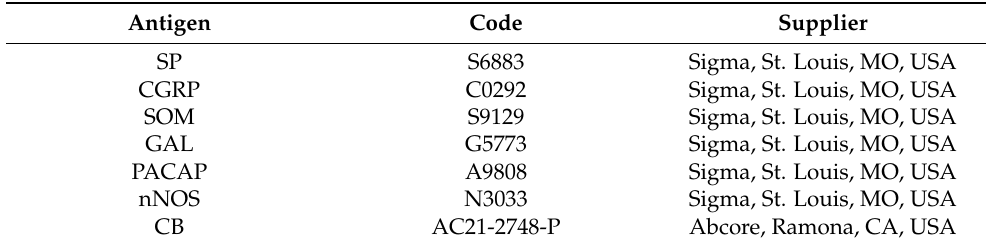
Table 4. List of antigens used in pre-absorption test.